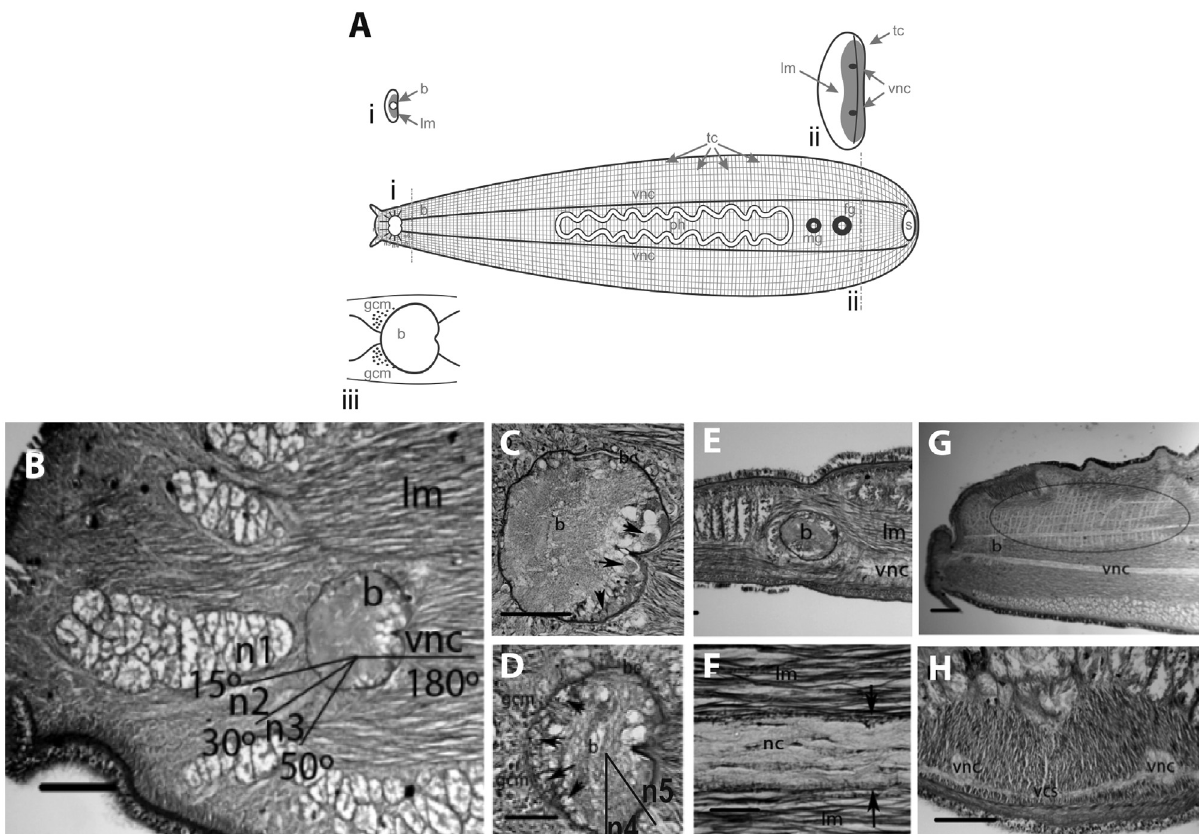
Figure 3 - Polyclad nervous system organization: Category III. A. Schematic representation includes cross sections at the level of the brain (i) and at the level of the n6 nerve pair (ii); detail of the brain is shown below (iii). B. Longitudinal section through the anterior region of Boninia divae , showing the distributionoftheventralnervousbranchesandimmersionofentirenervoussystemintothelongitudinalmusculature.Scalebar150 (cid:2) m. C. Longitudinal section through the ventral region of the B. divae brain . Arrows indicate the Type I cells in the posterior portion of the brain. Scale bar 75 (cid:2) m. D. Longitu- dinal section through the dorsal region of the B. divae brain. Arrows indicate Type III cells in the anterior portion of the brain. Notice that the globuli cell masses are formed by Type II cells that are poorly defined. Scale bar 75 (cid:2) m. E. Sagittal section of the B. divae brain, showing longitudinal musculature surrounding the nervous system. Scale bar 150 (cid:2) m. F. Sagittal section of the B. divae brain, showing a higher magnification through a ventral nerve cord submerged in longitudinal musculature. Notice that the nerve cord is surrounded by a thin sheath (arrows). Scale bar 100 (cid:2) m. G. Anterior sagittal section showing the parallel branches and transverse commissures in B. divae , forming the orthogonal pattern (portion circled). Scale bar 250 (cid:2) m. H. Cross sec- tion through a ventral commissure in B. divae . Scale bar 250 (cid:2) m. b brain, fg female gonopore, gcm globuli cell masses, mg male gonopore, n nerve cords, n6 major nerve cords, ph pharynx, s sucker, tc transversal